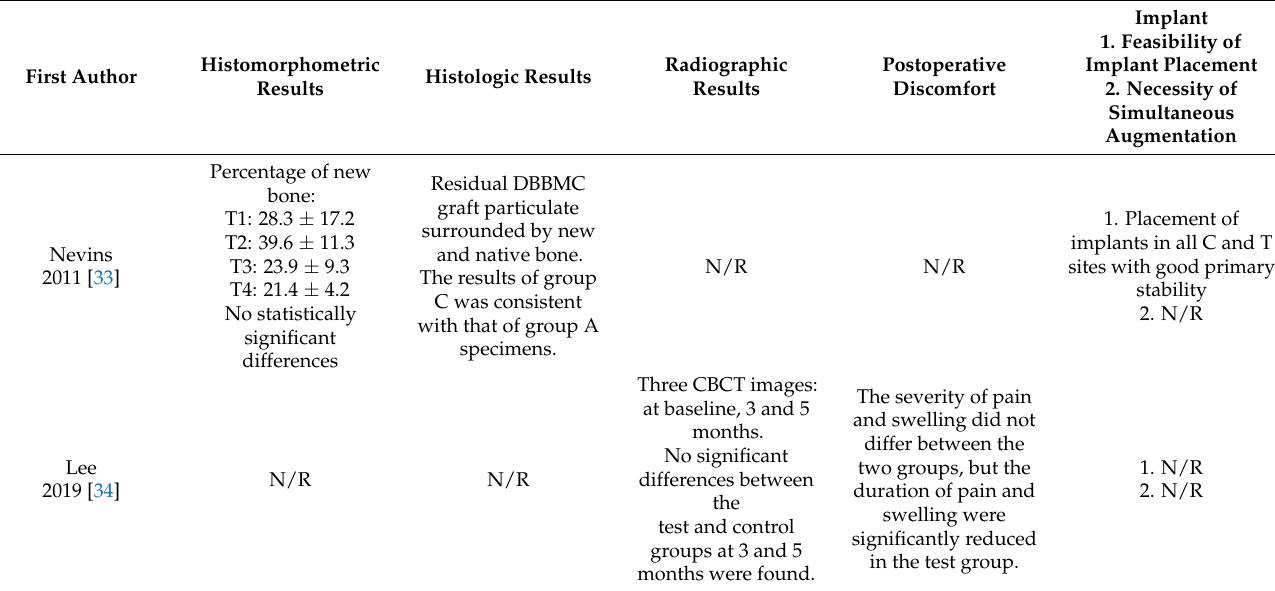
Table 2. Measurement method and outcomes of the included